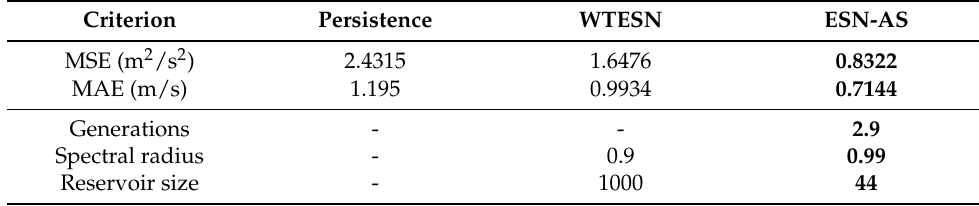
Table 5. Average test performance—MAC.